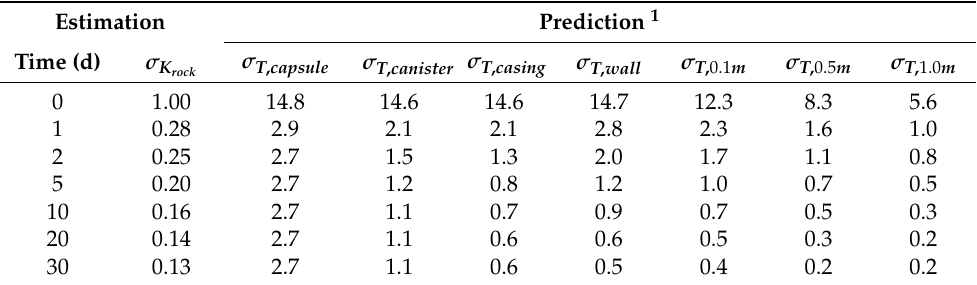
Table 3. Estimation and prediction uncertainties for select heater test